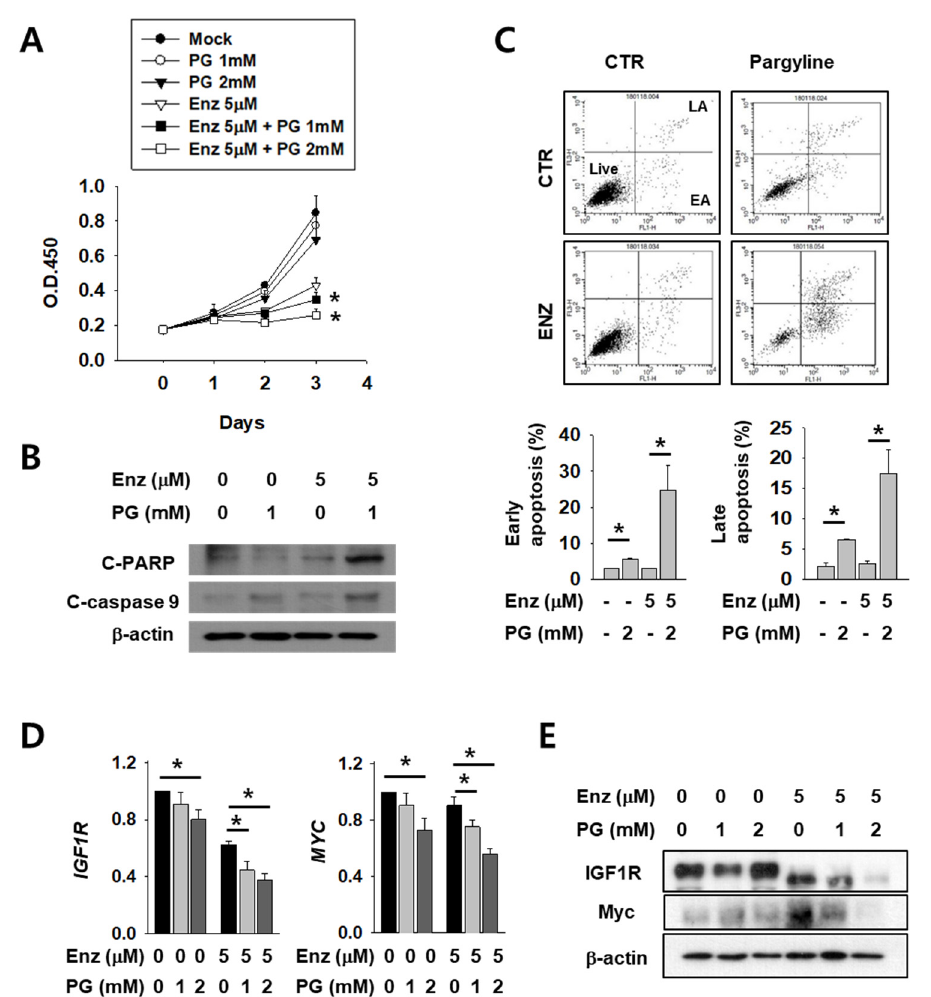
Figure 4. LSD1 inhibitor pargyline (PG) treatment attenuates kidney cancer growth and induces cell death additively with enzalutamide. ( A ) Caki-2 cells were treated with enzalutamide and / or the indicated concentrations of PG and the optical density values of viable cells were determined using EZ-Cytox solution. Bars represent the means ± SD of three independent experiments, and * denotes p < 0.05 (Student’s t -test) versus enzalutamide-only treated group. ( B ) After two days of treatment with the indicated drugs, the total cell lysates were collected and immunoblotted with the indicated antibodies. ( C ) Flow cytometry analysis of annexin V and propidium iodide (PI) staining of apoptotic cells following treatment of Caki-2 cells with the indicated drug for three days. The percentage of early apoptosis (EA) and late apoptosis (LA) cells are calculated and graphed below. Error bars represent the mean ± SD of three independent experiments and * denotes p < 0.05 (Student’s t -test) between the two indicated groups. ( D ) The mRNA levels of indicated genes in Caki-2 cells treated with enzalutamide and / or pargyline were analyzed by RT-qPCR. Error bars represent the mean ± SD of three independent experiments and * denotes p < 0.05 (Student’s t -test) between the two indicated groups. ( E ) Western blots of whole-cell lysates after 24 h of treatment with the indicated drugs and concentrations. Whole-cell lysates were immunoblotted with indicated antibodies.